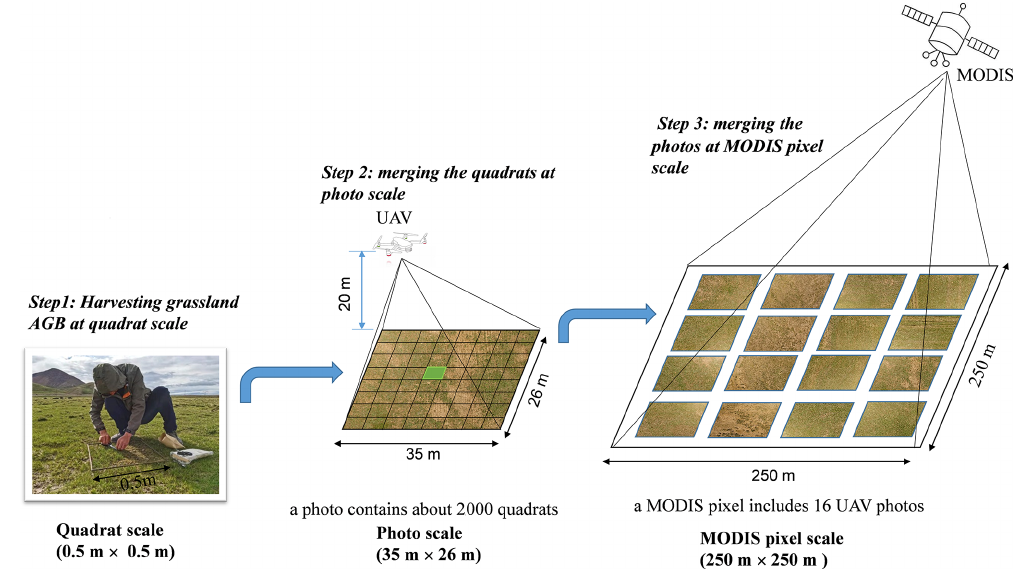
Figure 4. Upscaling steps to estimate grassland AGB matching the MODIS pixel scale.